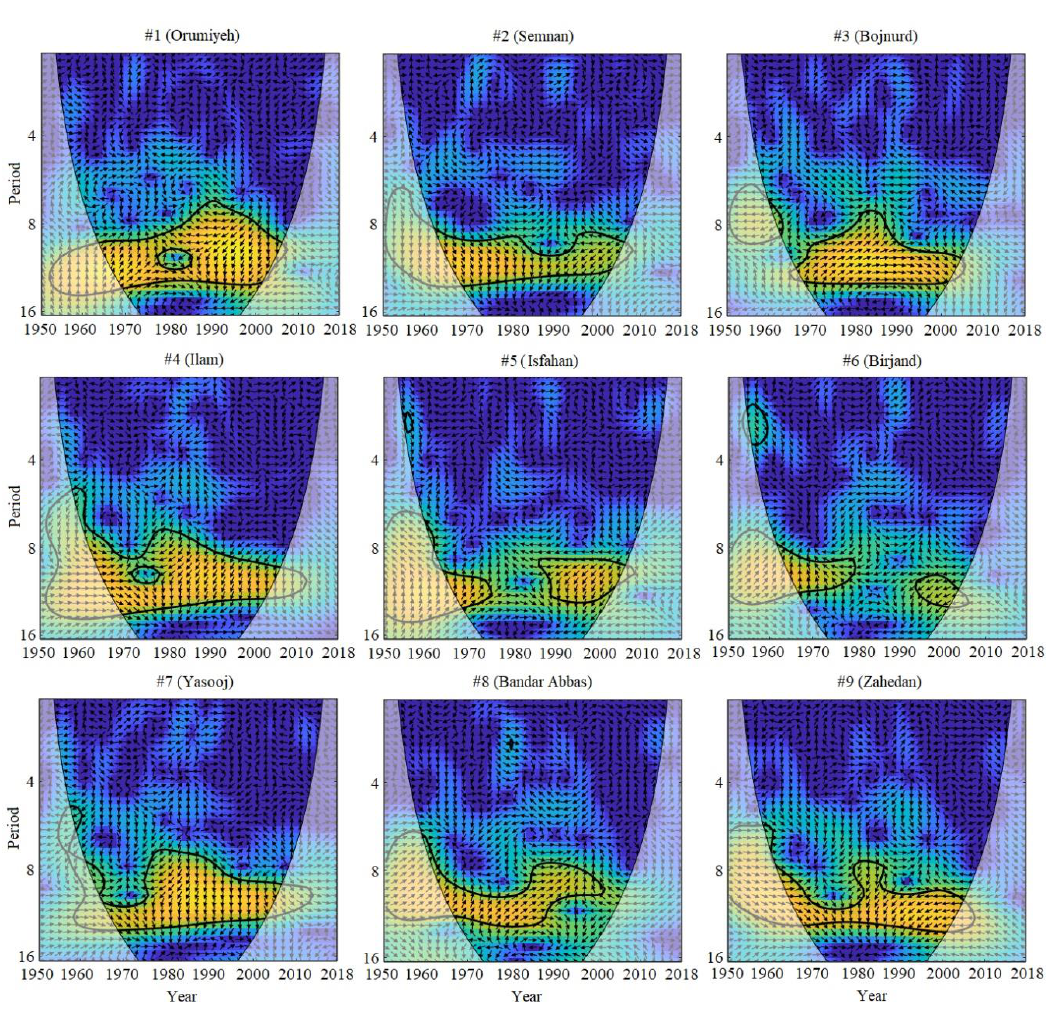
Figure 4. Cross-wavelet transform (XWT) analysis results in selected stations.